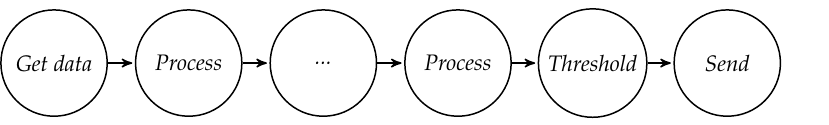
Figure 5. A simple chain of tasks: circles represent the tasks while the arrows represent the FIFOs that put them in